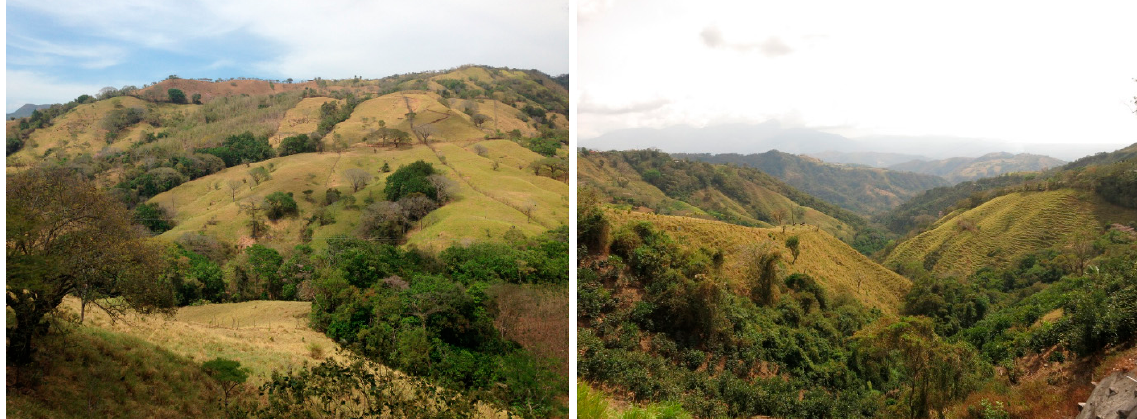
Figure 1. ( a ) HyMap RGB true color mosaic of study area (~30 × 30 km) located in central Costa Rica near San Jose; ( b ) Digital elevation model of the study area; ( c ) Location within the country.